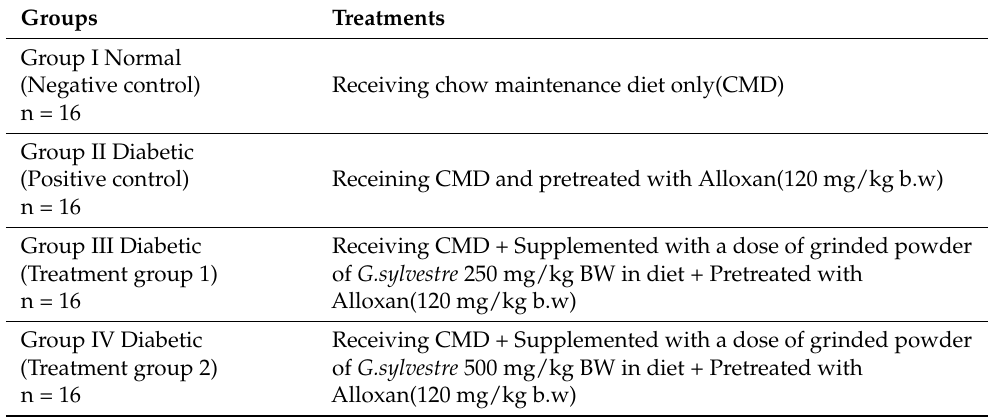
Table 1. Detail of different groups and their subsequent